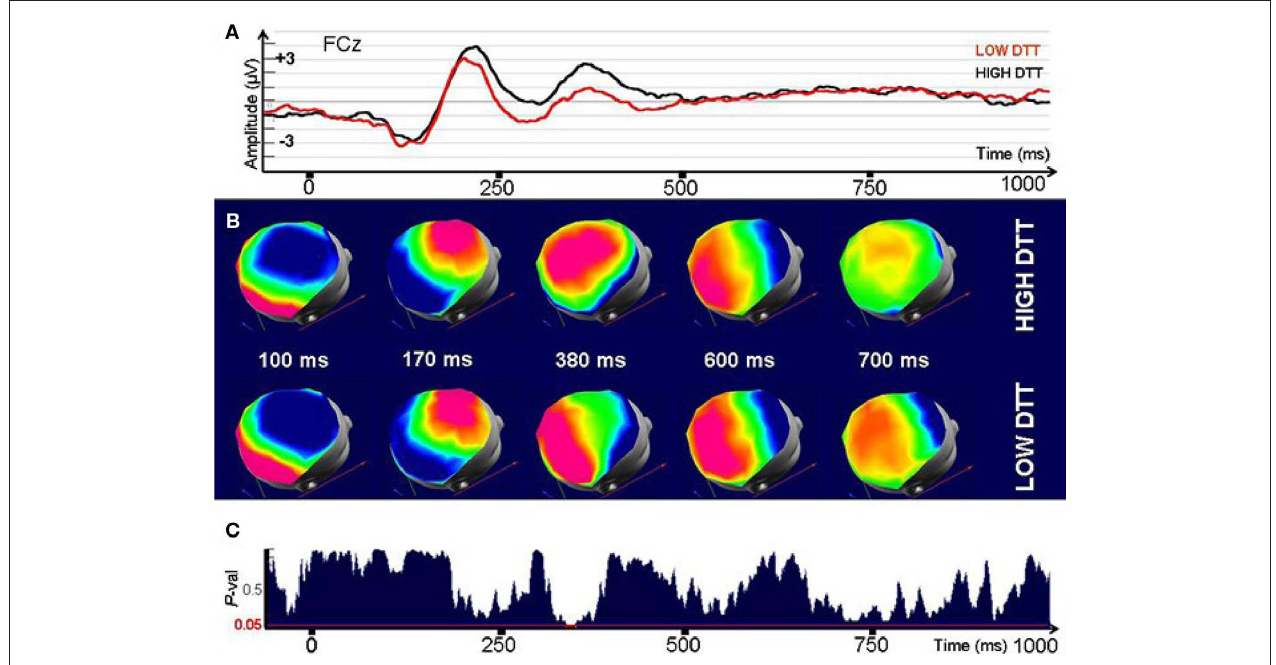
FiGurE A7 | Electrophysiological comparison between High and Low-DTT groups under elation. (A) Signals recorded at a fronto-central electrode (FCz) after presentation of the Positive (Elation) outcomes at time 0. (B) Evolution through time of the corresponding Event-Related Potential maps (C) P -value for a randomized MANOVA performed on the maps. Threshold for significant differences ( P < 0.05) is indicated by the red line. A significant difference is observed during 20 ms (380–400